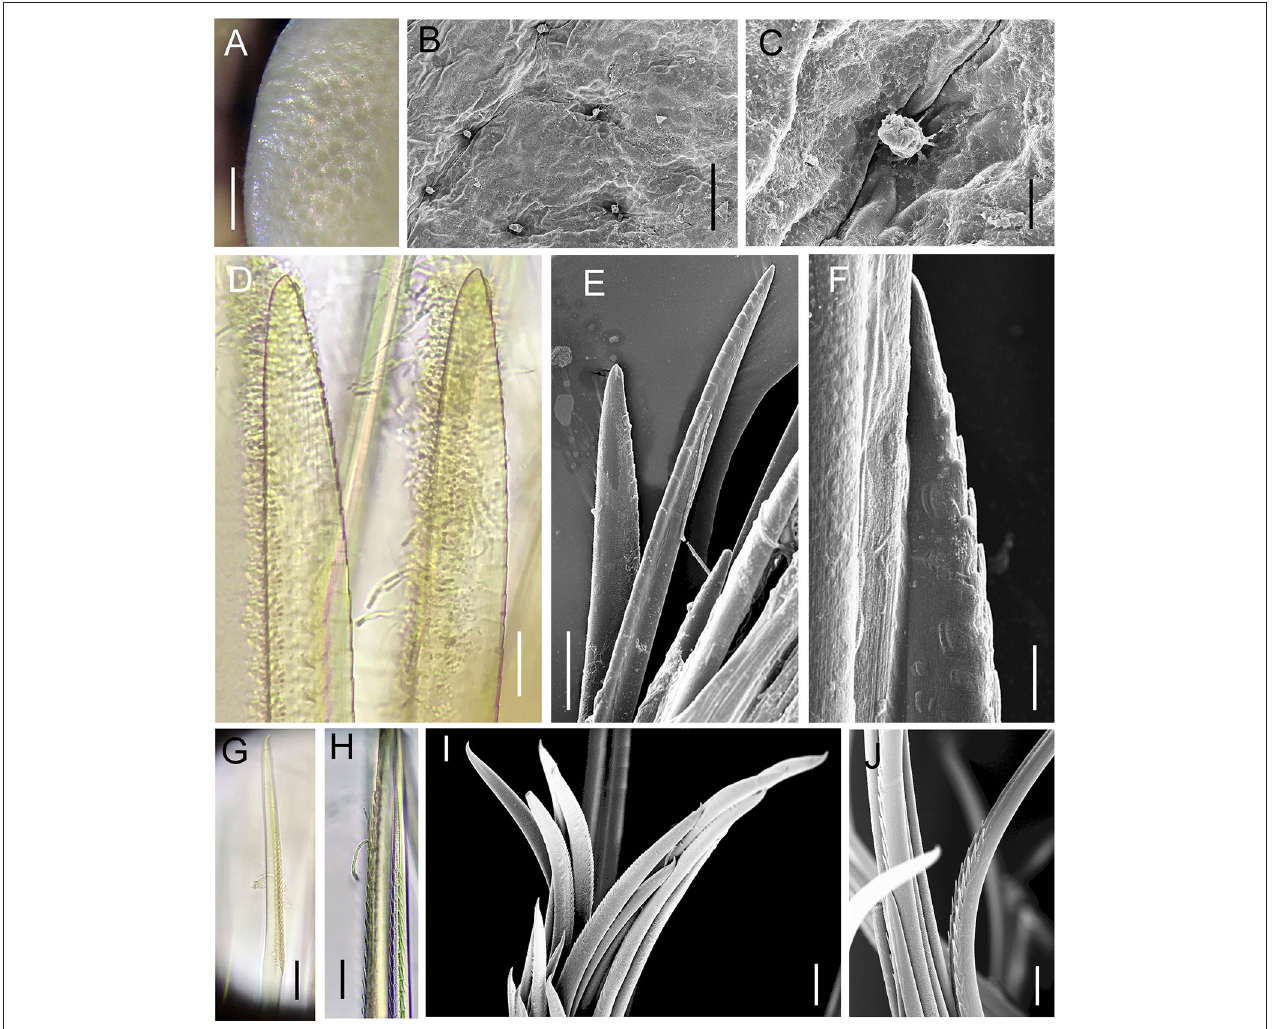
FIGURE 8 | Lepidonotopodium okinawae . Details of scale ( A–C , from Specimen 3) and chaetae ( D–H , from Specimen 10). (A–C) foveolae and micropapillae on the elytral surface. (D–E) shorter notochaetae from the dorsal side. (F) lower longer notochaetae. (G–J) neurochaetae. (D–J) are all from 10th right parapodium. Scale bar: (A) 0.5mm; (B) 80 µ m; (E) 40 µ m; (F,H) 10 µ m; (D,E,G,I,J) 20 µ